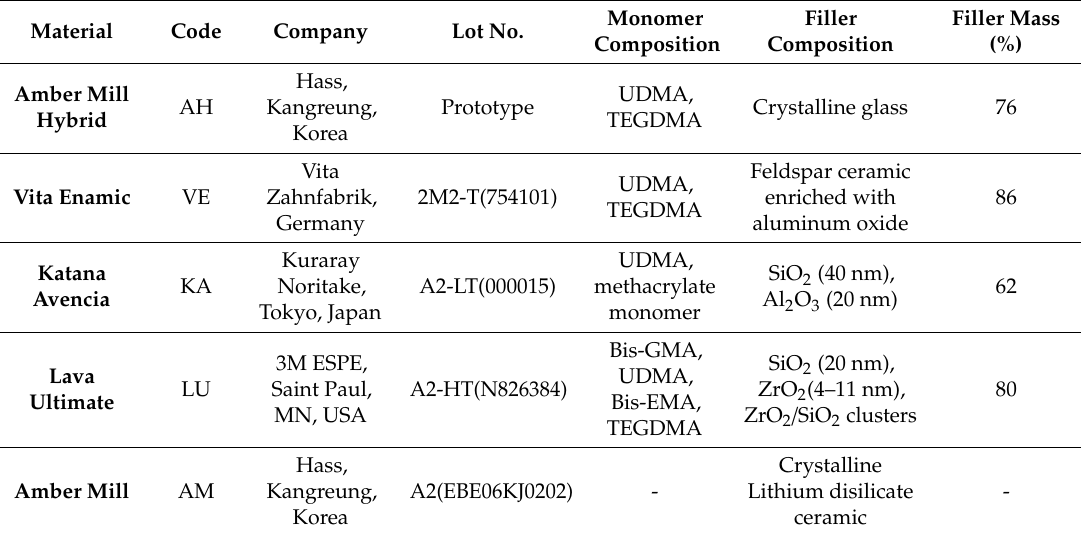
Table 1. Characteristics of the materials used in the